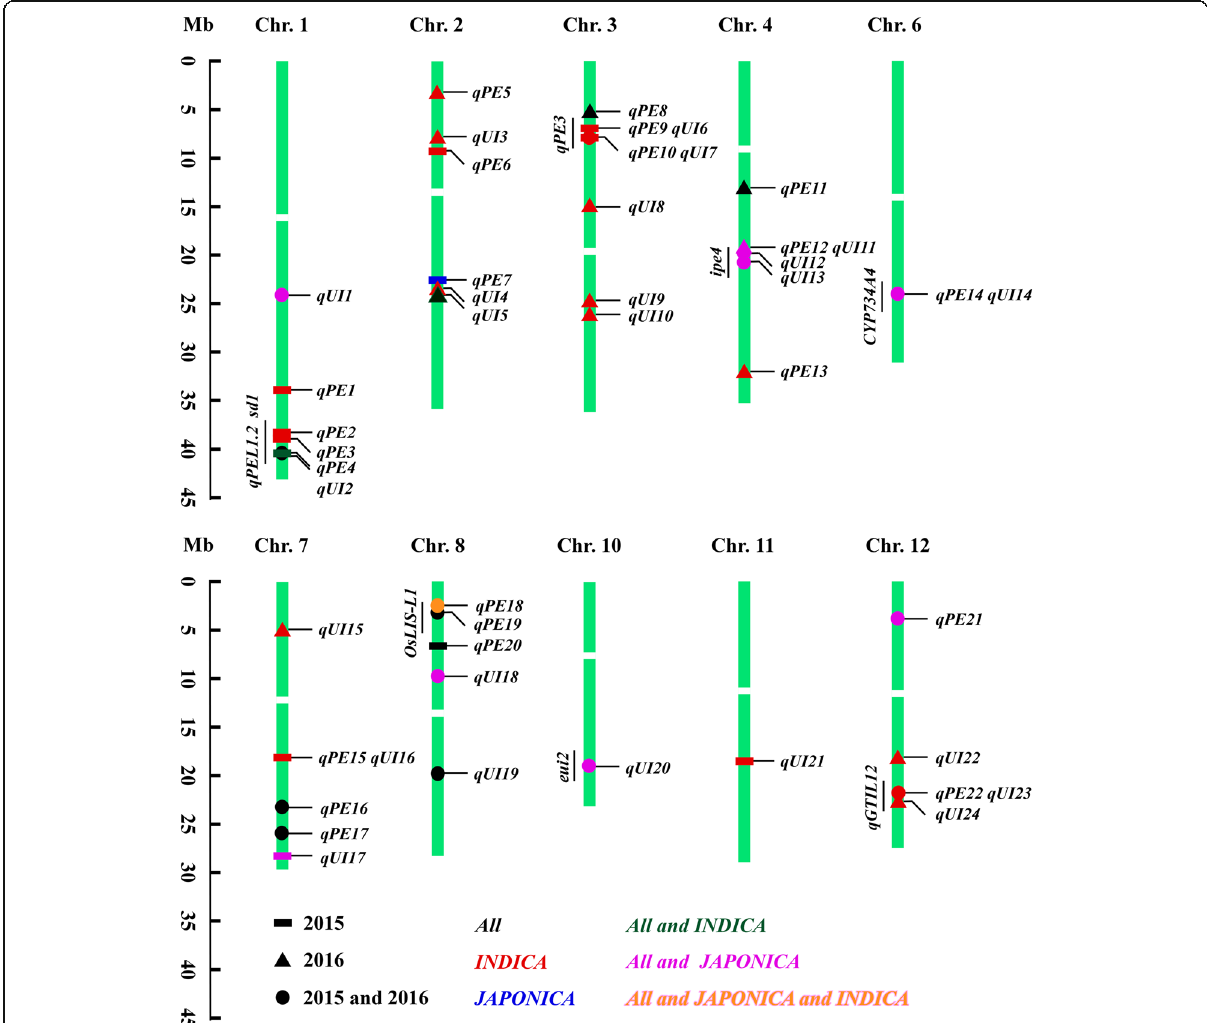
Fig. 4 Chromosomal positions of loci for PE and UI identified via GWAS in All , JAPONICA , and INDICA groups in 2015 and 2016. The mapped loci in this study are shown on the right, and previously mapped QTLs are shown on the